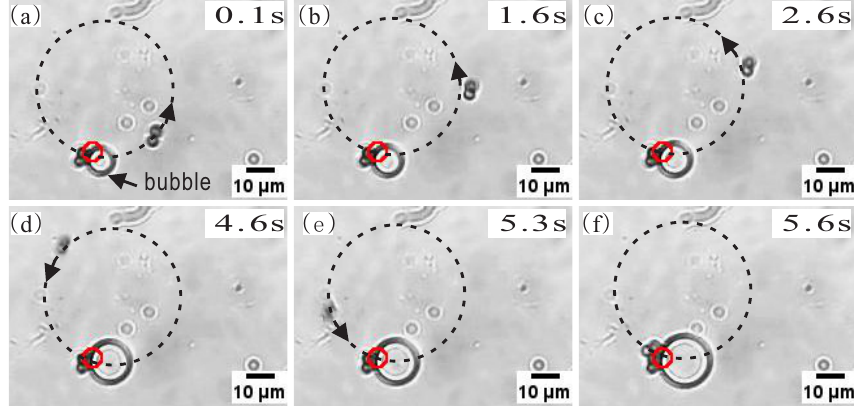
Figure 7. Images of AP movement driven by Marangoni flow observed with a high magnification objective (N.A. = 1.1). The small red circle indicates the laser focus. The large dot circle indicates the trajectory of particle motion. The arrow in the dotted circle indicates the movement direction. P = 80 mW. Scale bar, 10 µ